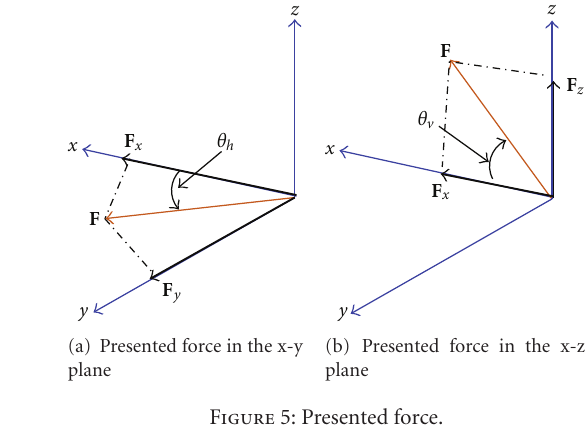
Figure 5: Presented force.